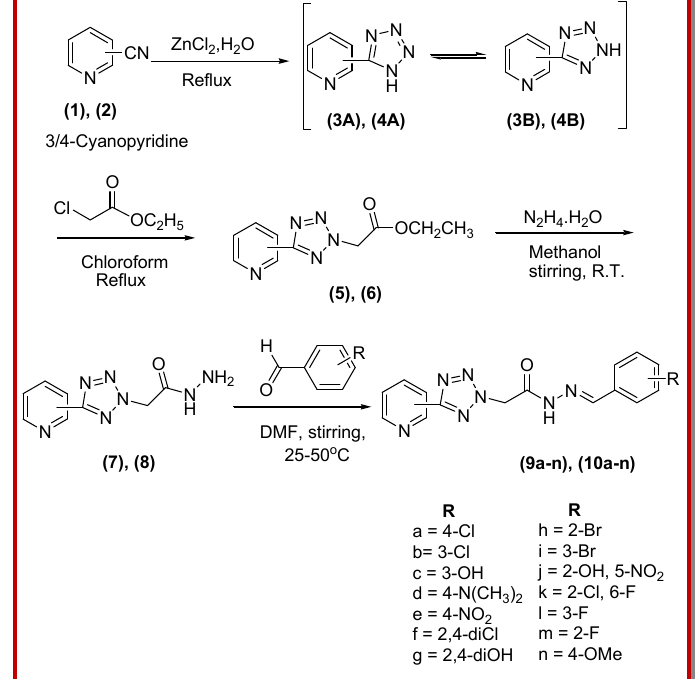
Scheme 1: Synthesis of N ΄ -( substituted-benzylidene)-2-(5-(pyridin-3/4-yl)-2 H -tetrazol-2-yl)aceto hydrazides